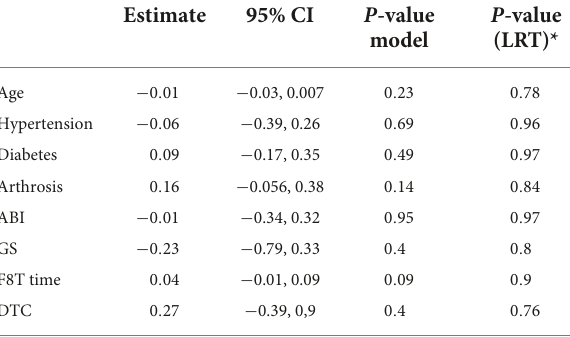
TABLE 4 Linear mixed effects models of changes of CBF across the tests in the dual-task paradigm adjusted for clinical